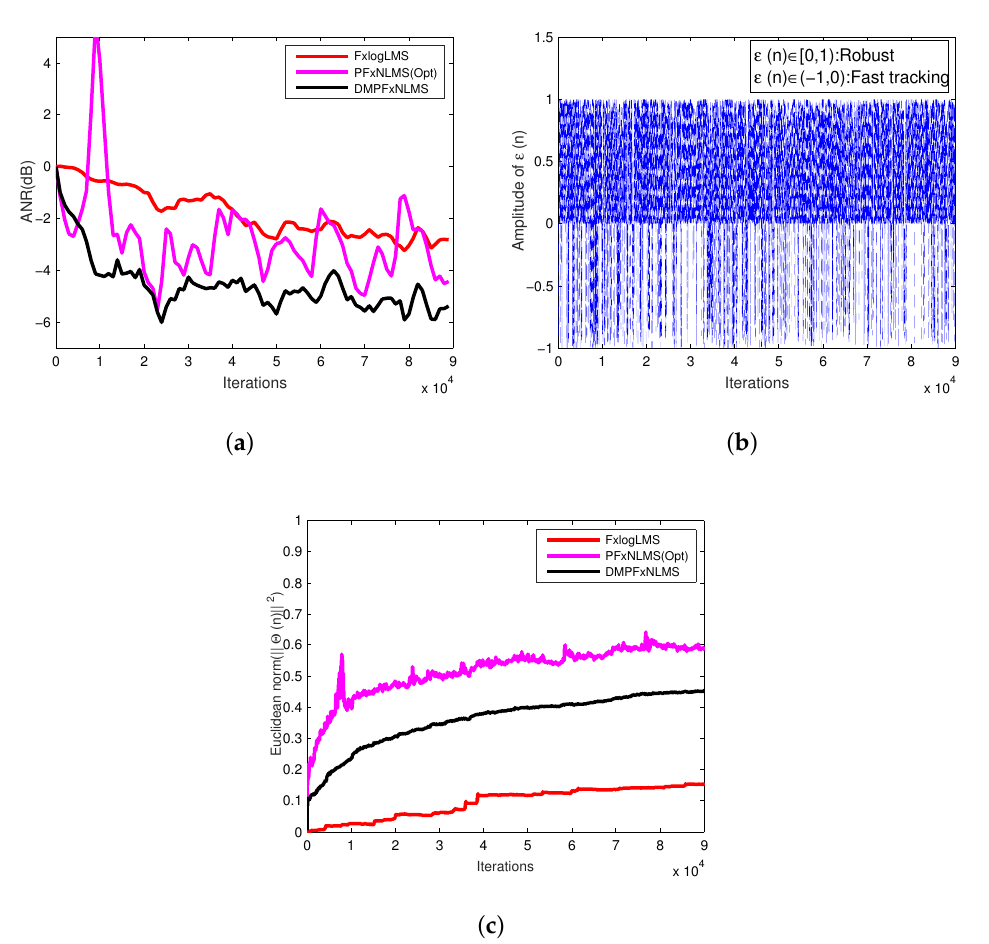
Figure 8. Robustness analysis ( a ) ANR curves; ( b ) changing process of ε ( n ) ; ( c ) Euclidean norm of weight vector Θ ( n )